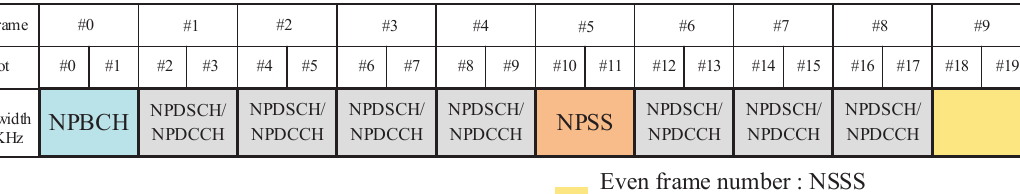
Figure 1. Diagram of the distribution of physical channels and physical signals in one NB-IoT radio